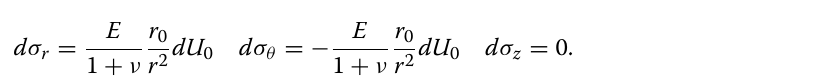
Fig. 5 Yield zone around the expanding